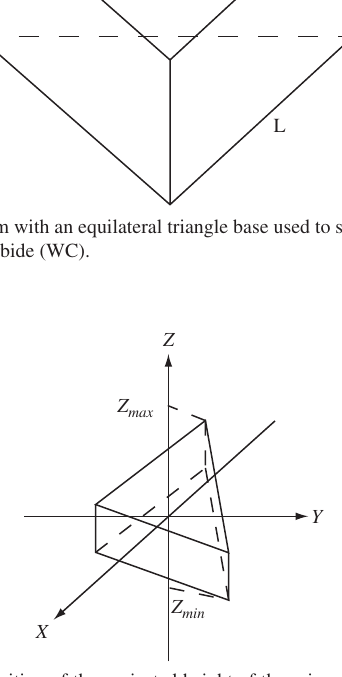
Figure 3. Definition of the projected height of the prism in the Z direction. The same can be done in the directions X and Y